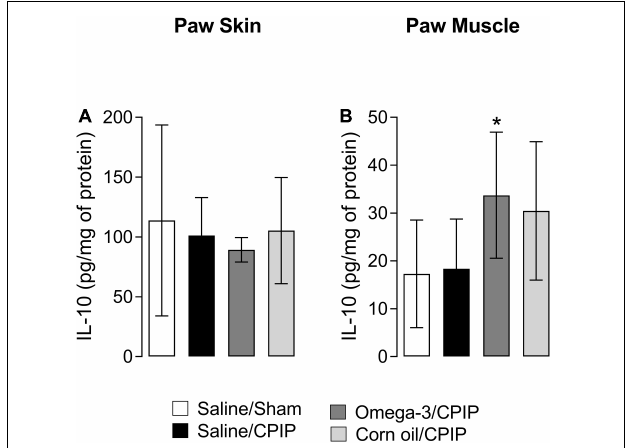
FIGURE 6 | Interleukin-10 concentrations in the paw skin and muscle 15 days after the induction of the CPIP model. IL-10 concentrations in the skin (A) and muscle (B) of Saline/Sham, Saline/CPIP, Omega-3/CPIP, and Corn oil/CPIP groups. Data are expressed as mean ± SD of 6–7 animals per group, assessed by the one-way ANOVA followed by Tukey’s test. * p < 0.05 vs. the Saline/CPIP